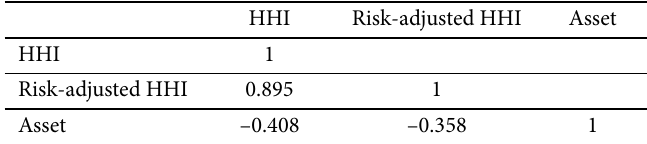
Table 6. Correlations of hhi, risk-adjusted hhi and asset hhi